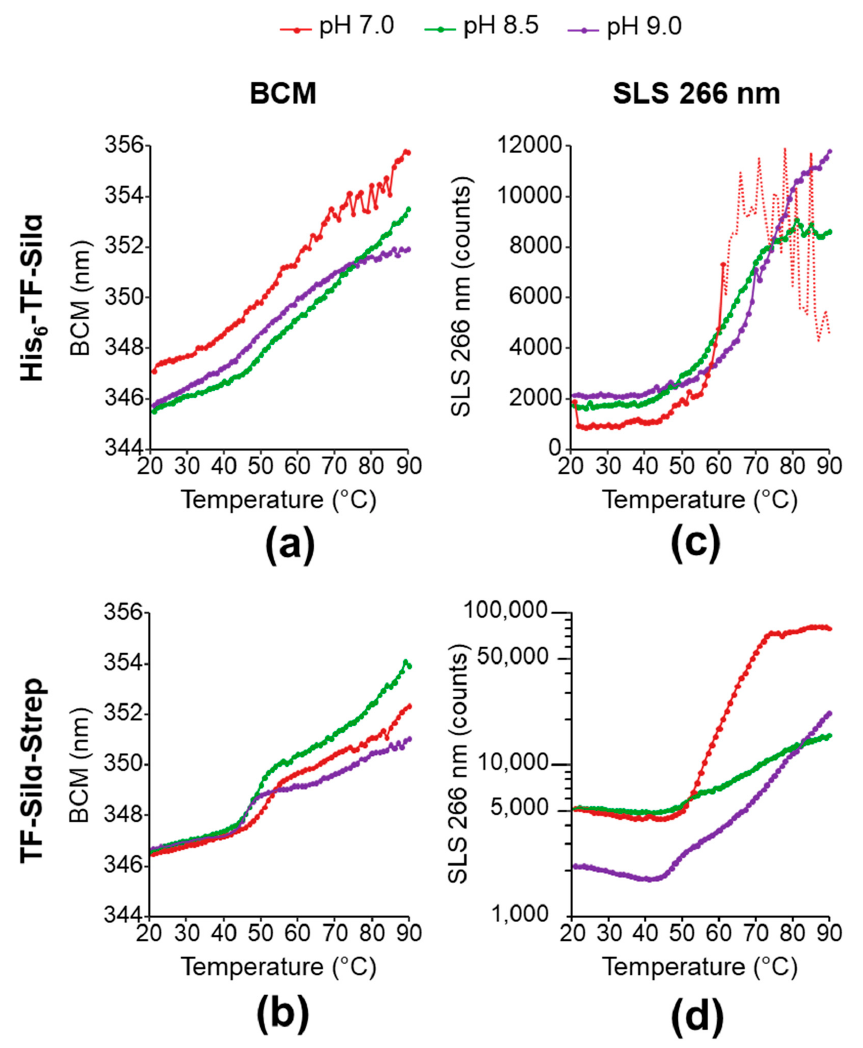
Figure 5. Data from a thermal ramp of silicatein protein constructs: ( a , b ) show the barycentric mean (BCM) of the intrinsic fluorescence spectra for His 6 -TF-Sil α and TF-Sil α -Strep respectively; ( c , d ) show the static light scattering (SLS) at 266 nm during the thermal ramp for His 6 -TF-Sil α and TF-Sil α -Strep respectively. The dotted line in ( c ) indicates measurements that are likely to be erroneous due to precipitation (see discussion for details).